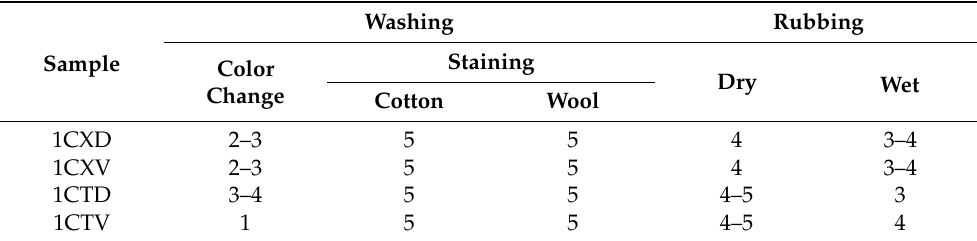
Table 8. Results of the washing and rubbing fastness tests of the pre-mordanted samples after dyeing with